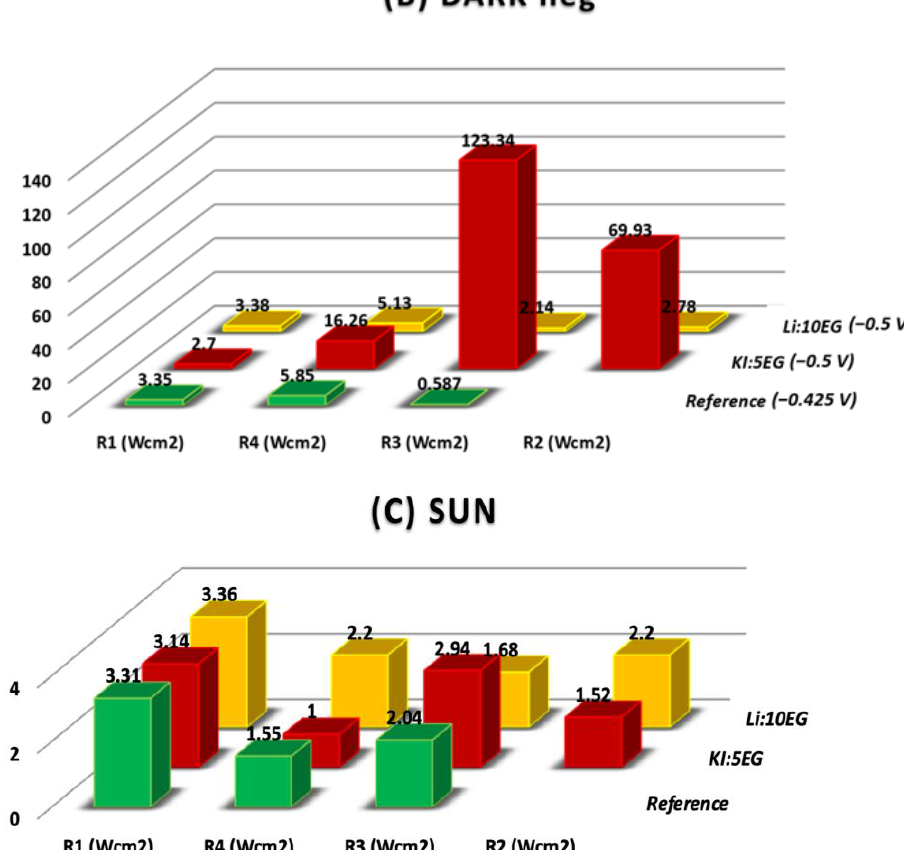
Figure 5. Resistance values obtained for the different alkali iodides based-DES plus 0.5 mol % I 2 incorporated as electrolyte for DSSCs. Legend: ( A ) DARK pos; ( B ) DARK neg; and, ( C ) SUN.